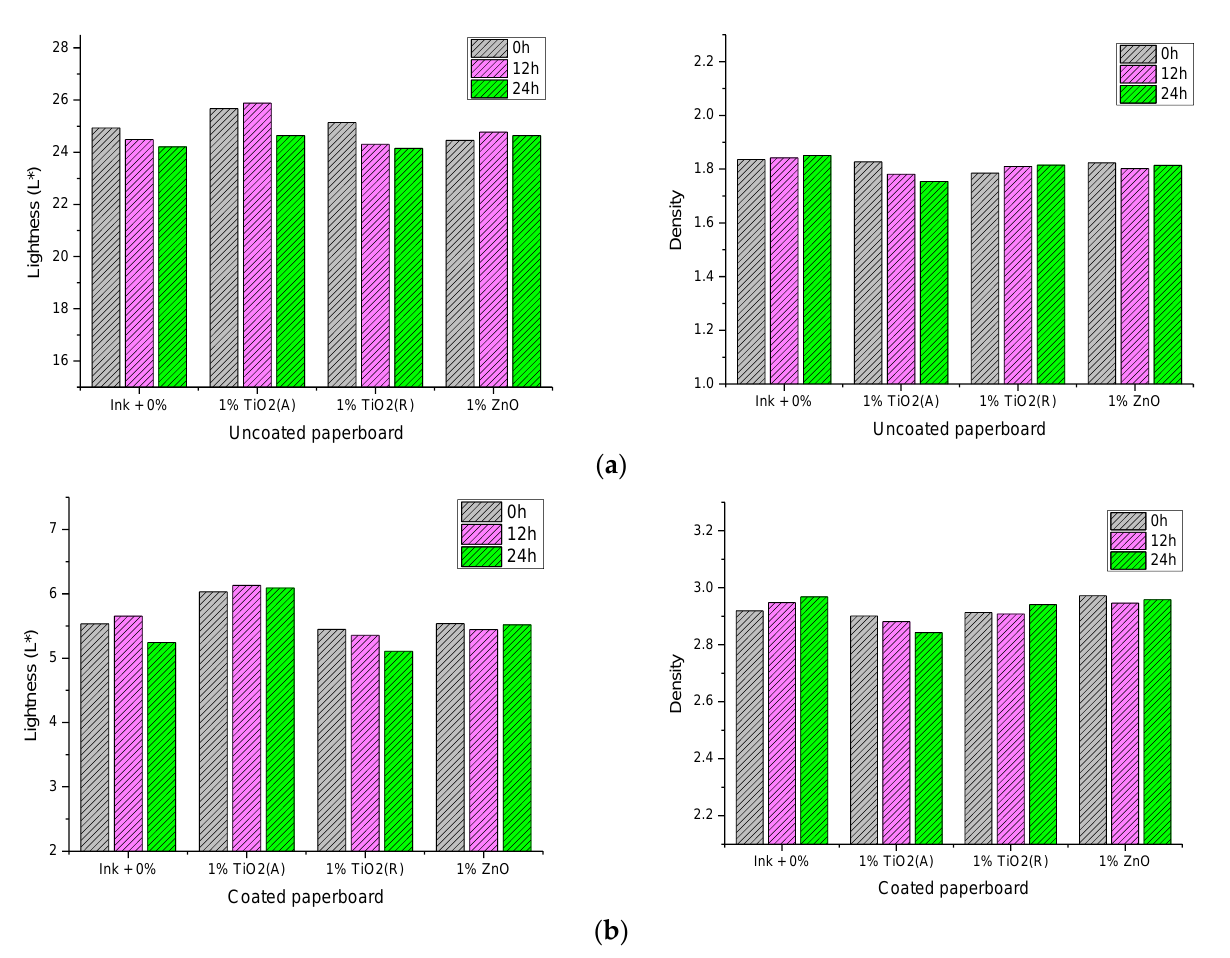
Figure 11. Results of the CIE L* values and color density of unmodified and modified ink films; ( a ) uncoated and ( b ) coated paperboard.